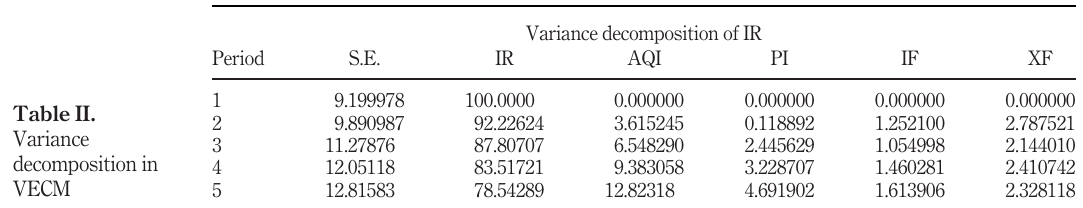
Figure 1. Impulse response combined graph in VECM